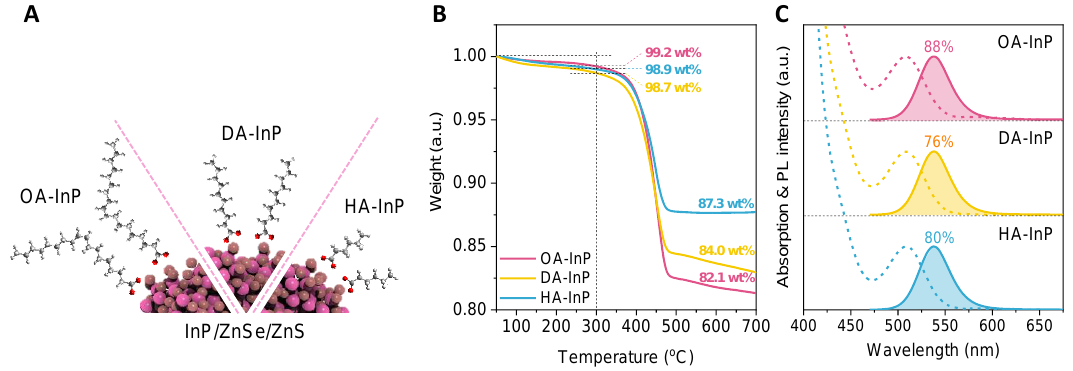
Figure 1. ( A ) A schematic representation of the InP/ZnSe/ZnS QDs with varying lengths of surface-ligands; ( B ) the thermogravimetric analysis and ( C ) the steady-state absorption and photoluminescence spectra of the InP/ZnSe/ZnS QDs before and after the ligand substitution reactions. The values above the spectra indicate the relative quantum yields relative to that of coumarin 153 in ethanol.